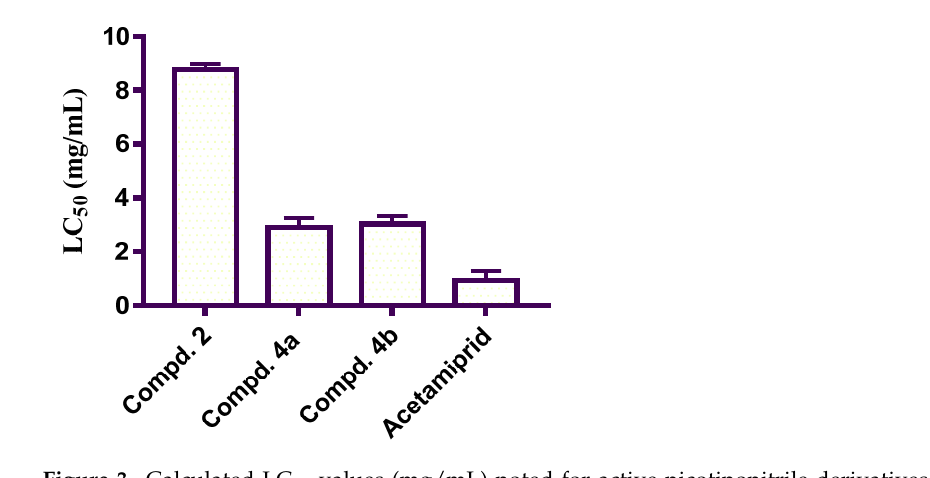
Figure 3. Calculated LC 50 values (mg/mL) noted for active nicotinonitrile derivatives 2 , 4a , 4b , compared with that of Acetamiprid against M. cartusiana land snails.